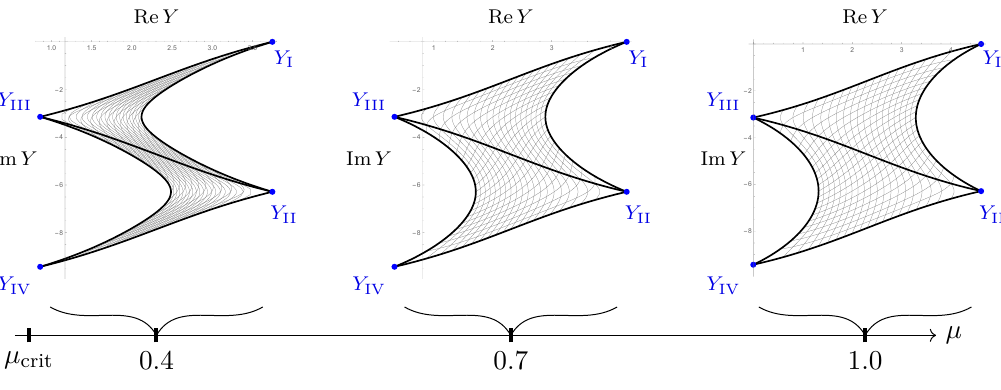
Figure 9 . Shrinking holomorphic disk movie in CP 1